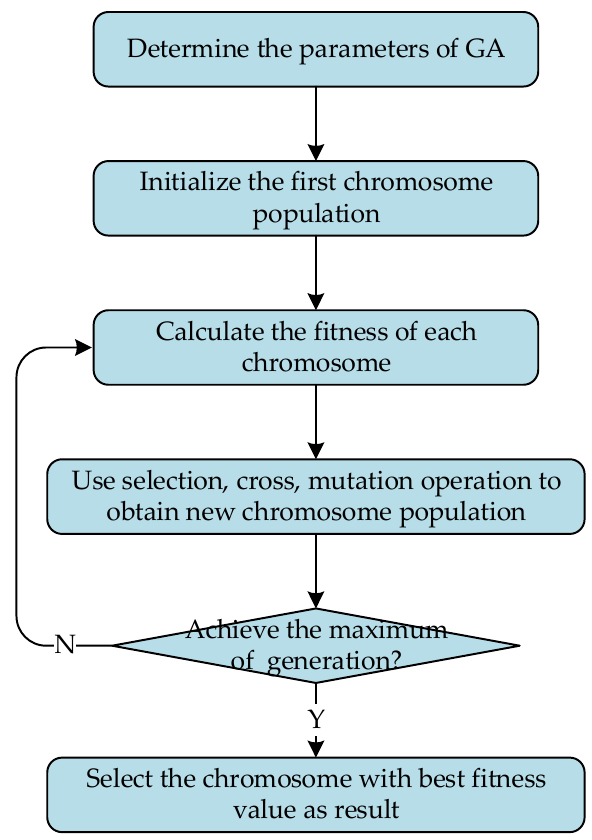
Figure 3. The flowchart of GA.